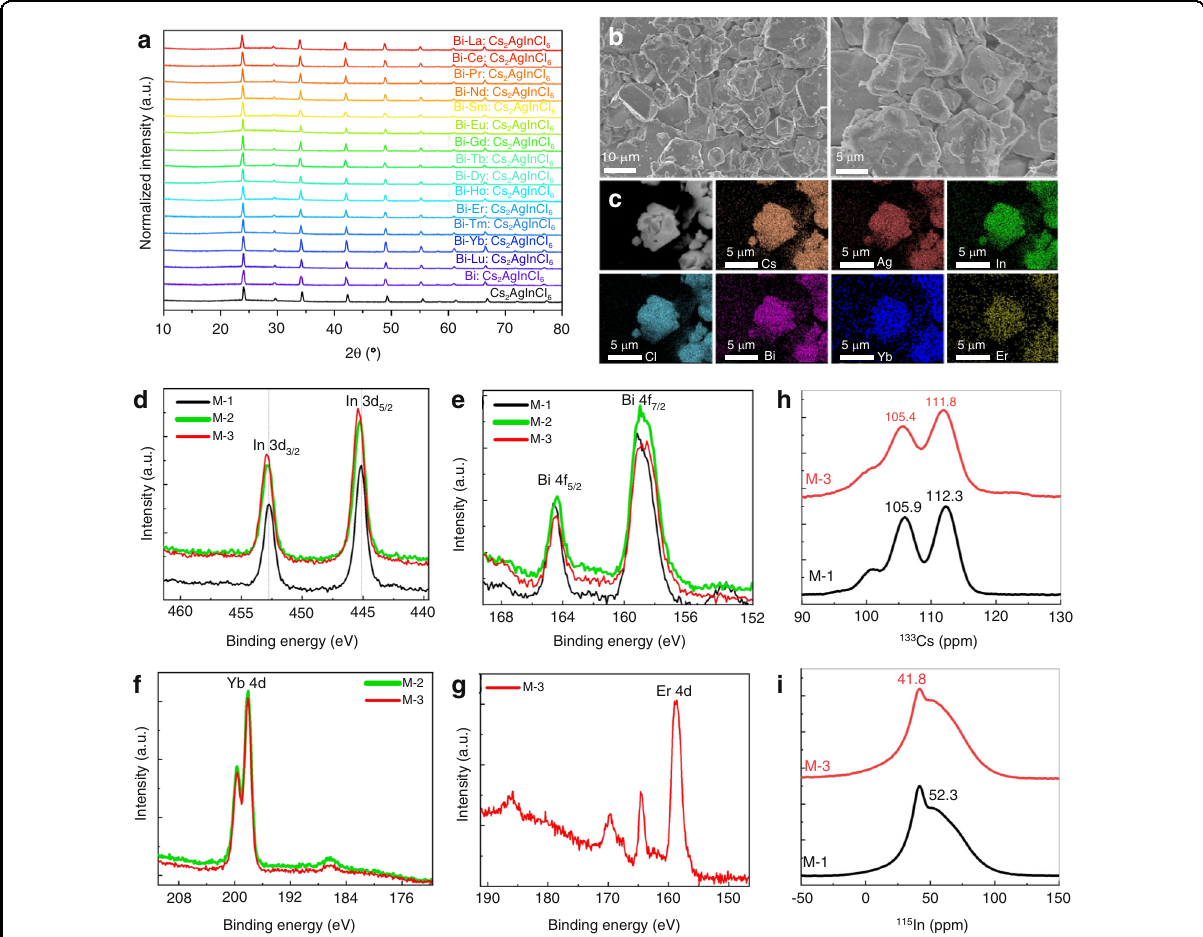
Fig. 1 Structural characterization of Bi/Ln:Cs 2 AgInCl 6 DPs. a XRD patterns of Bi/Ln:Cs 2 AgInCl 6 DPs. b SEM images of a typical Bi/Yb/Er:Cs 2 AgInCl 6 sample and ( c ) the corresponding EDX mappings. d – g XPS spectra of the In 3d, Bi 4f, Yb 4d, and Er 4d orbitals of M-1 (Bi:Cs 2 AgInCl 6 , black line), M-2 (Bi/Yb:Cs 2 AgInCl 6 , green line), and M-3 (Bi/Yb/Er:Cs 2 AgInCl 6 , red line) samples. h 133 Cs and i 115 In NMR spectra of the M-1 and M-3